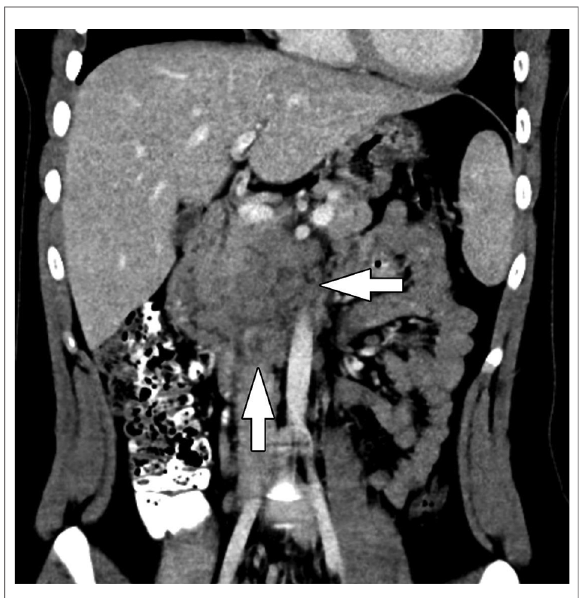
FIGURE 5 Acinar cell carcinoma. Coronal CT of the abdomen obtained in the portal venous phase following intravenous contrast material administration shows an in fi ltrative, hypoenhancing mass involving the head and uncinate process of the pancreas with adjacent conglomerate pathologic lymph node enlargement